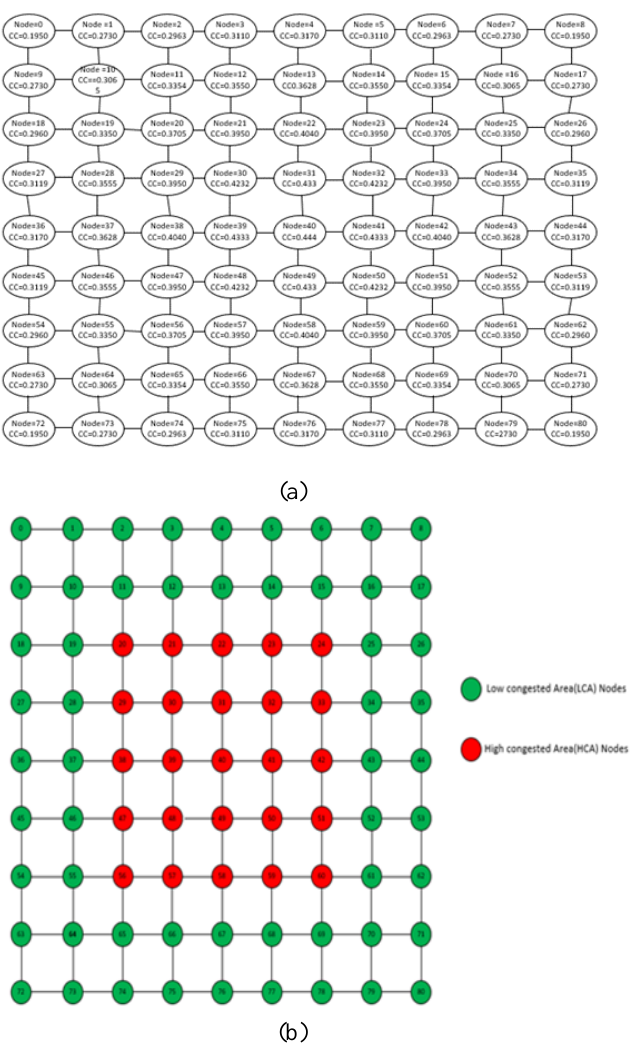
Fig. 2. (a) 9x9 2D mesh Network with closeness certainty value. (b) The network is partitioned into two are HCA and LCA based on a threshold